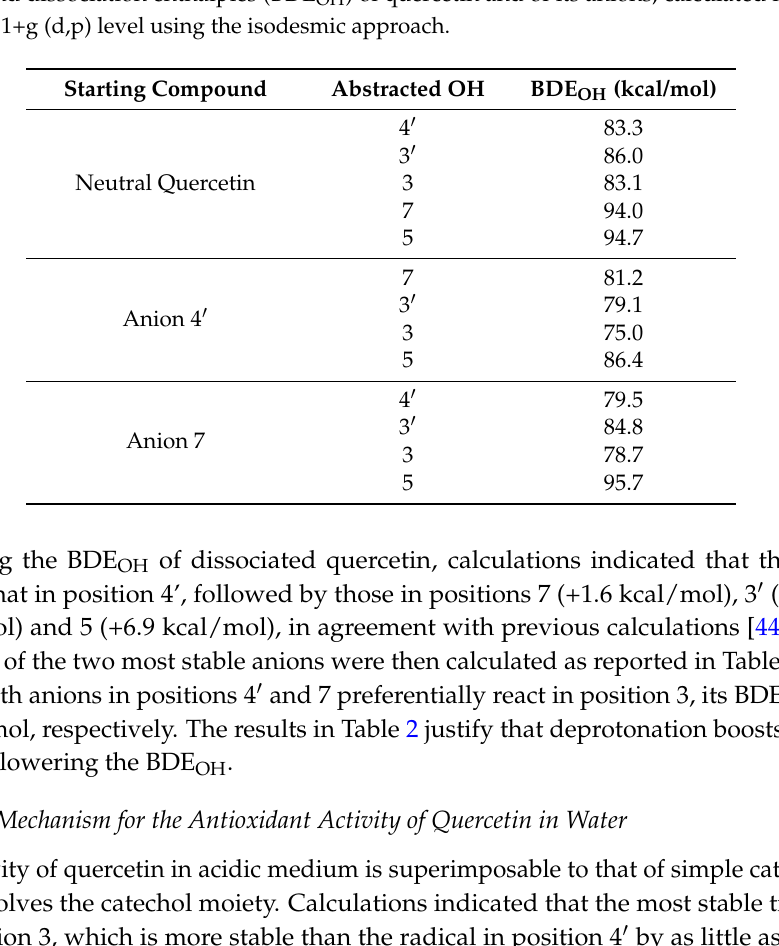
Table 2. Bond dissociation enthalpies (BDE OH ) of quercetin and of its anions, calculated in water